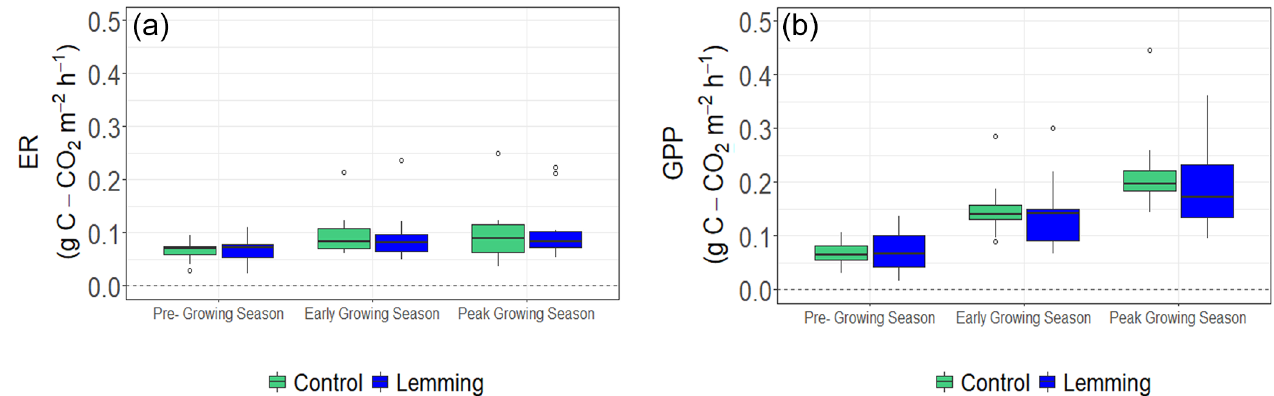
Figure 4. Box and whisker plots of ER and GPP for control and lemming plots during the three rounds of data collection in summer 2019. Positive flux values indicate a positive respiration (carbon loss into the atmosphere) and a positive carbon uptake by vegetation through photosynthesis. (a) Median ER ( T = − 0 . 34, P = 0 . 742), and (b) median GPP ( T = − 0 . 37, P = 0 . 716). The signs of ER and GPP are always positive, but if ER is more than GPP, then the ecosystem is a carbon source into the atmosphere (with a positive sign of NEE).